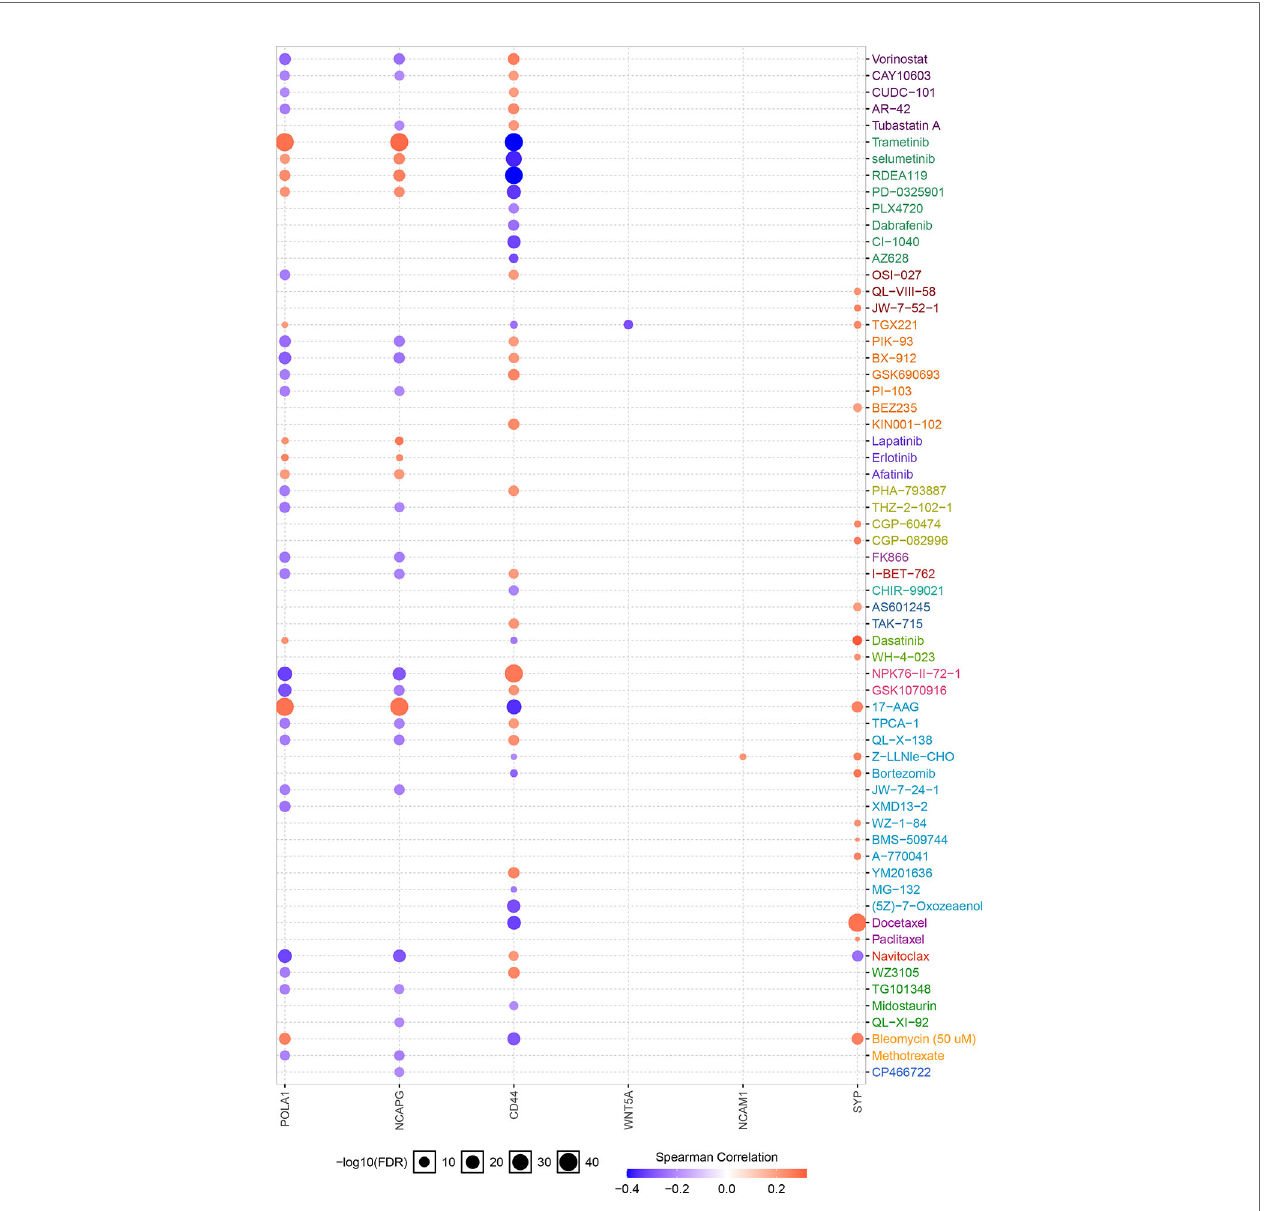
FIGURE 7 | Correlation between hub gene expression levels and small molecule/drug sensitivity via the online search tool